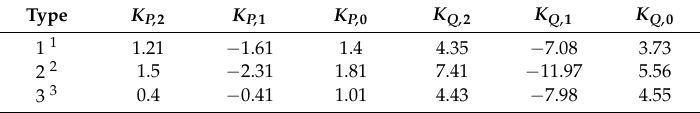
Table 2. Constant impedance-current-power (ZIP) model